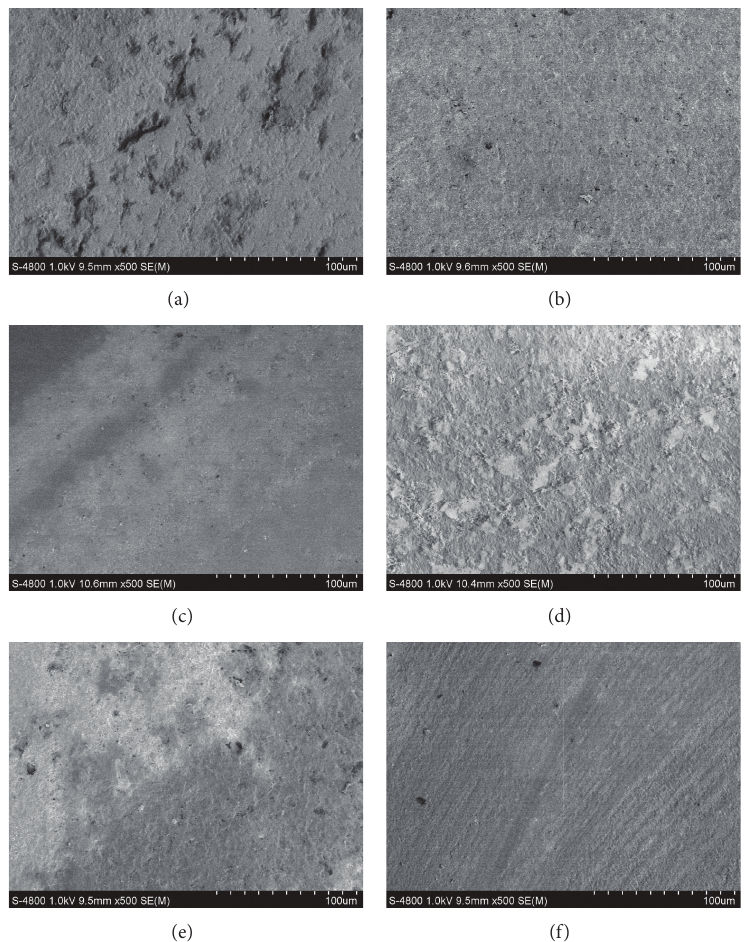
Figure 10: Surface machined at (a) 𝐴 = 0 𝜇 m, 𝑎 𝑝 = 2𝜇 m, 𝑓 𝑤 = 100 𝜇 m, 𝑛 = 18000 r/min; (b) 𝐴 = 6.5 𝜇 m, 𝑎 𝑝 = 2 𝜇 m, 𝑓 𝑤 = 100 𝜇 m, 𝑛 = 18000 r/min; (c) 𝐴 = 7.5 𝜇 m, 𝑎 𝐴 = 8.5